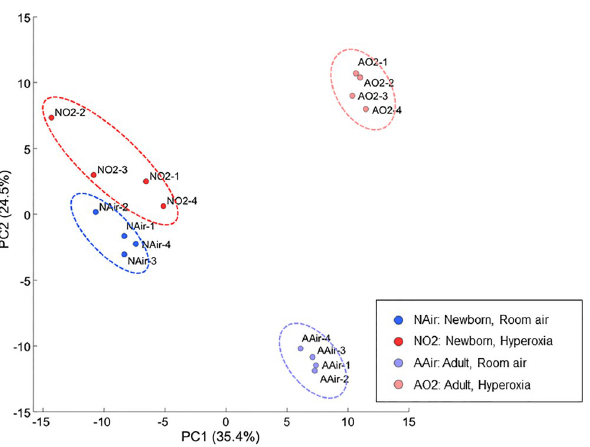
Fig 2. Principal component analysis of the metabolomic dataset of the four groups. Percentage on the axes represent the contribution rate of the first (PC1) and second (PC2) principal components. PC1 and PC2 had contribution ratios of 35.4% and 24.5%, respectively, and were sufficient to distinguish the four groups. Ellipses are graphical representations of groups without any statistical support. NAir, newborn, room air; NO2, newborn hyperoxia; AAir, adult room air; AO2, adult, hyperoxia; PC, principal component.